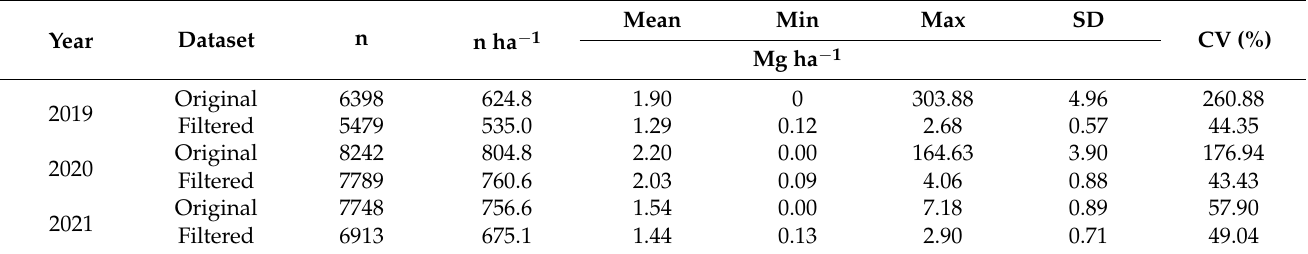
Table 2. Descriptive statistics of yield data after filtering for the three evaluated crops.